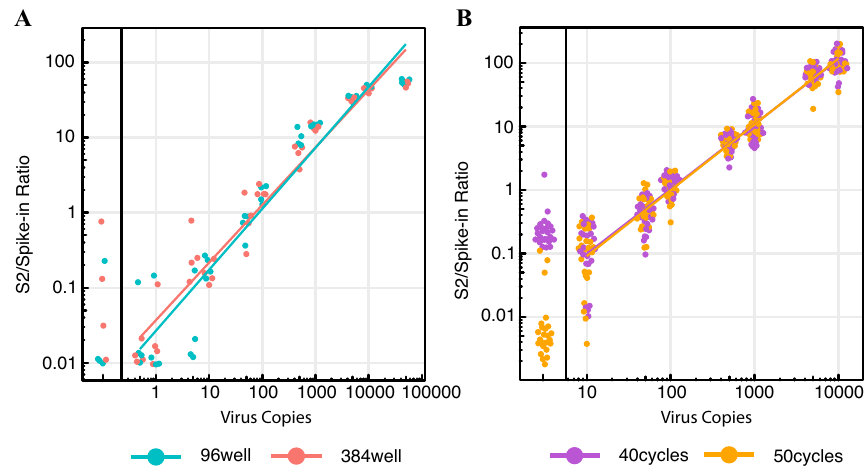
Figure 3. Swab-Seq in Saliva. ( A ) Comparison of 96-well and 384-well formats for testing saliva samples over a wide range of concentrations (0.5 to 100,000 copies per reaction). Points are colored by the plate format (96-well vs 384-sell). ( B ) Comparison of enzyme, denaturation time, and PCR cycle number in saliva. Points are colored by PCR cycle number here. For both ( A ) and ( B ), black vertical lines partition 0 copies of virus from the serial dilutions. Each dot is an individual well of a plate with the specified concentration. The colored lines are least- squares fitted lines incorporating all non-zero data